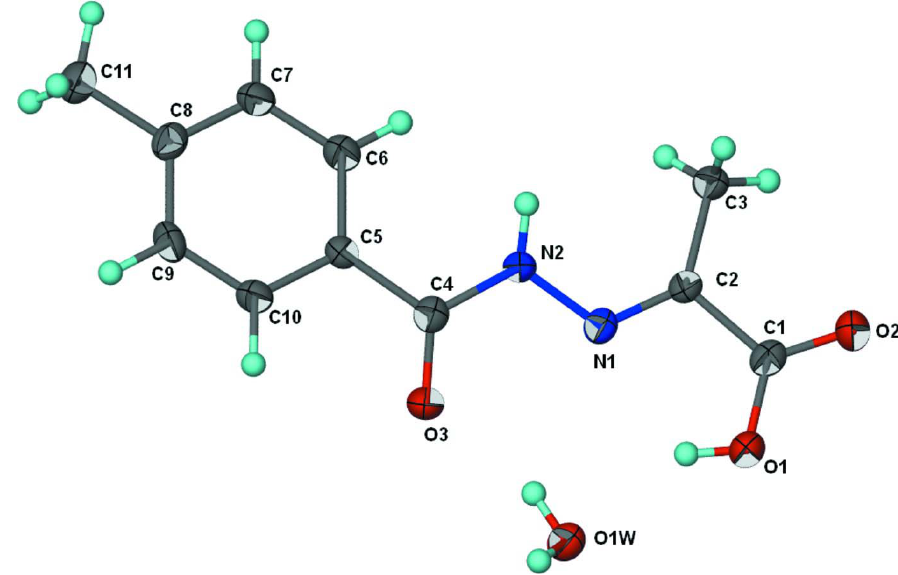
Figure 1 Displacement ellipsoids plot (Barbour, 2001) of the title compound at the 70% probability level. Hydrogen atoms are drawn as spheres of arbitrary